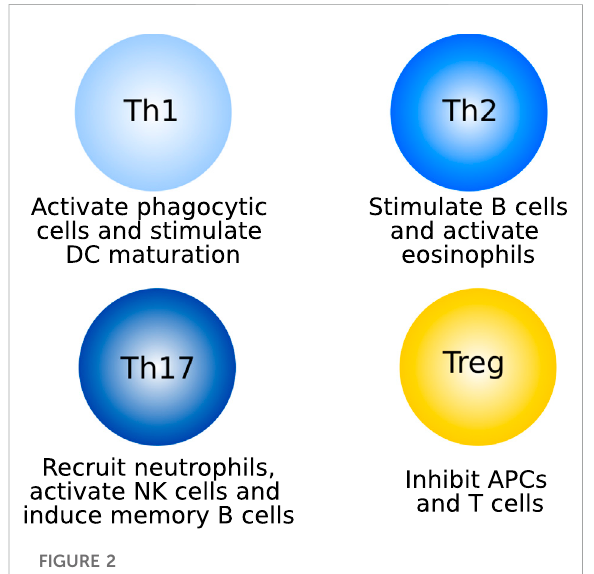
FIGURE 2 Main functions of the four CD4 + T cell subtypes. FIGURE 3